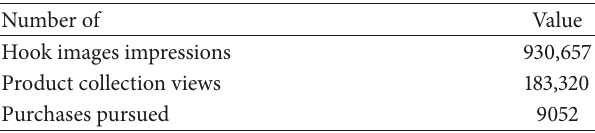
Table 2: Platform statistics during